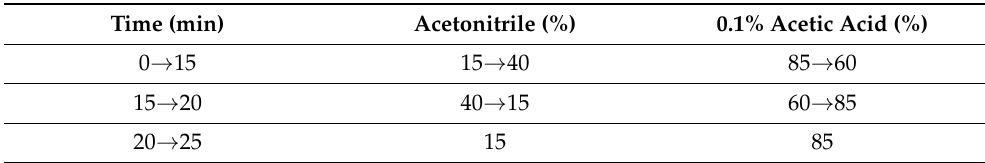
Table 8. HPLC gradient elution